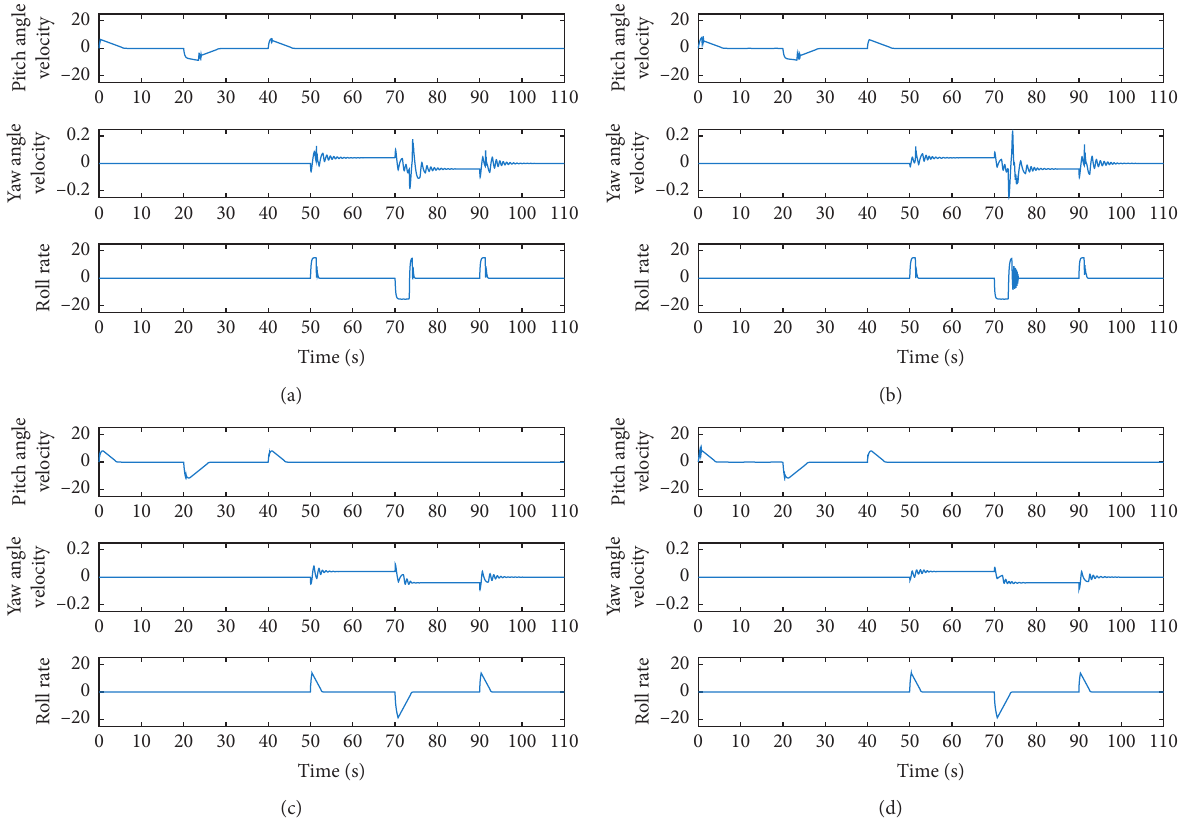
Figure 6: Angular velocity curves in the four cases: (a) angular velocity curve with baseline without uncertainties, (b) angular velocity curve with baseline under uncertainties, (c) angular velocity curve with optimal parameters without uncertainties, and (d) angular velocity curve with optimal parameters under